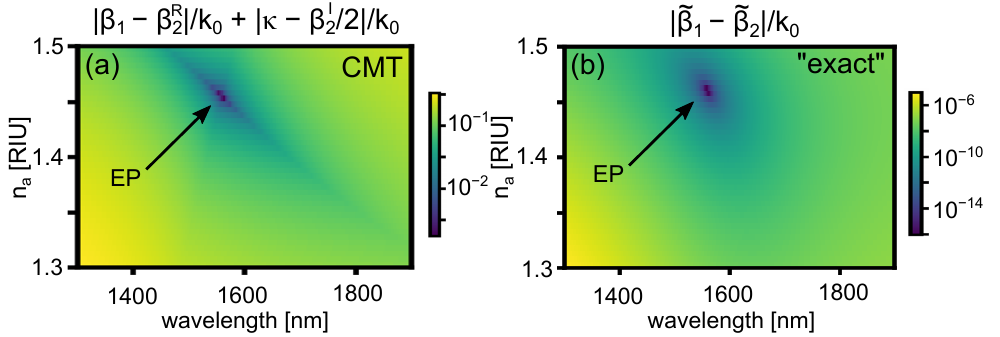
| / k + | κ − β I /2 | / k 0 using CMT and ( b ) | ˜ β 1 − 0 2 2